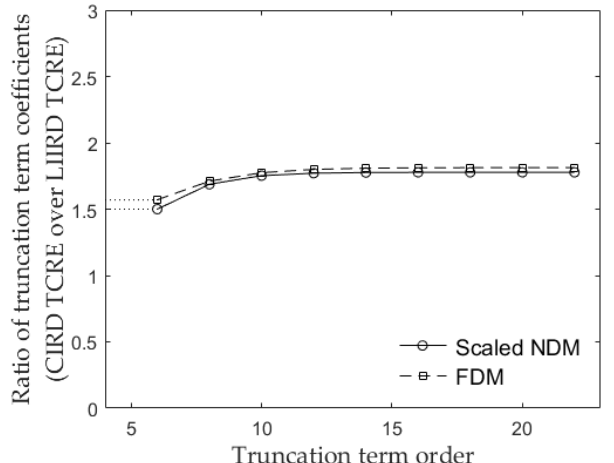
Figure 6. Ratios of truncation term coefficients for term orders 6 to 22 (CIRD TCRE over LIIRD TCRE) based on the scaled (by a factor of 2/3) NDM and the FDM respectively.